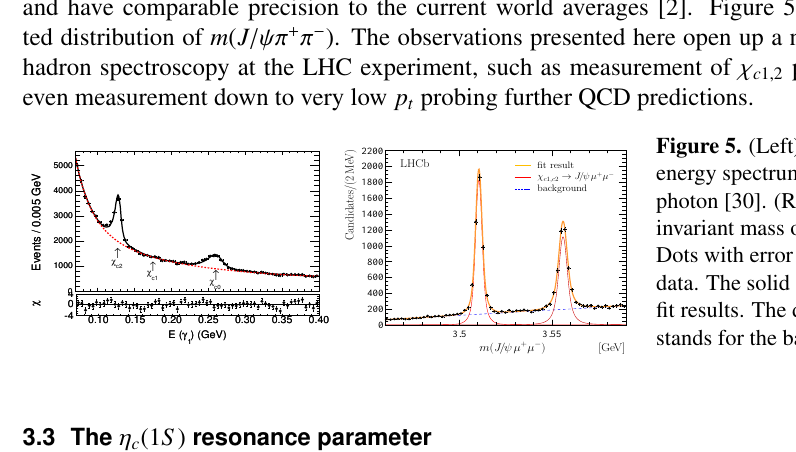
Figure7.3:Residual(left)andpull(right)distributionsforthefinalfitfromFig.7.2.